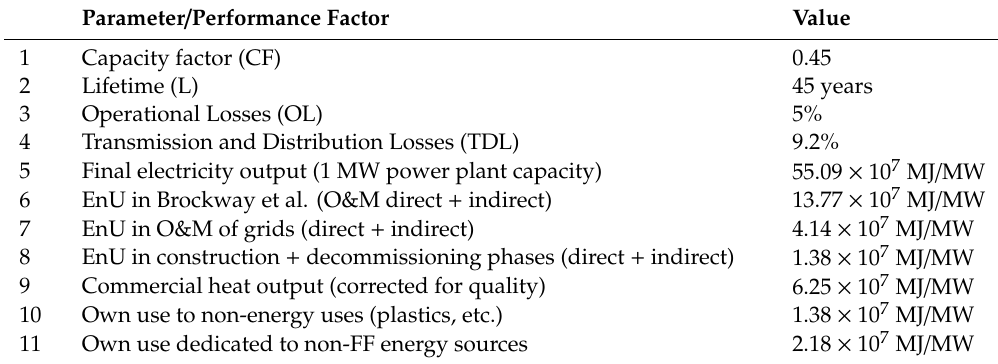
Table A2. Parameters and performance factors assumed for FF power plants in order to compare Brockway et al. [16] with our results for RES power